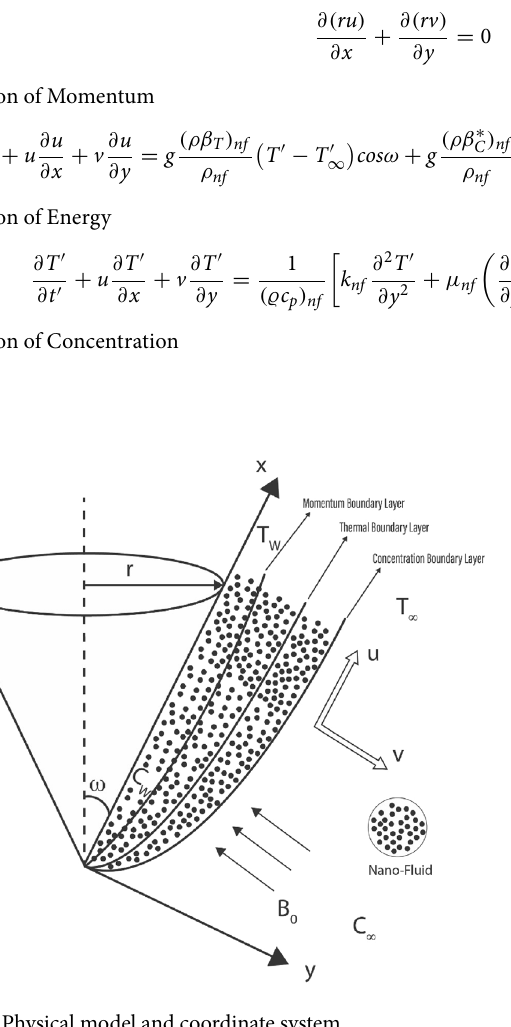
Figure 1. Physical model and coordinate